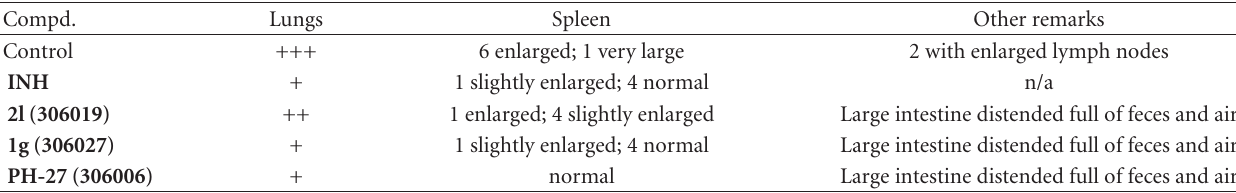
Table 4: In vivo e ffi cacy and observation at time of